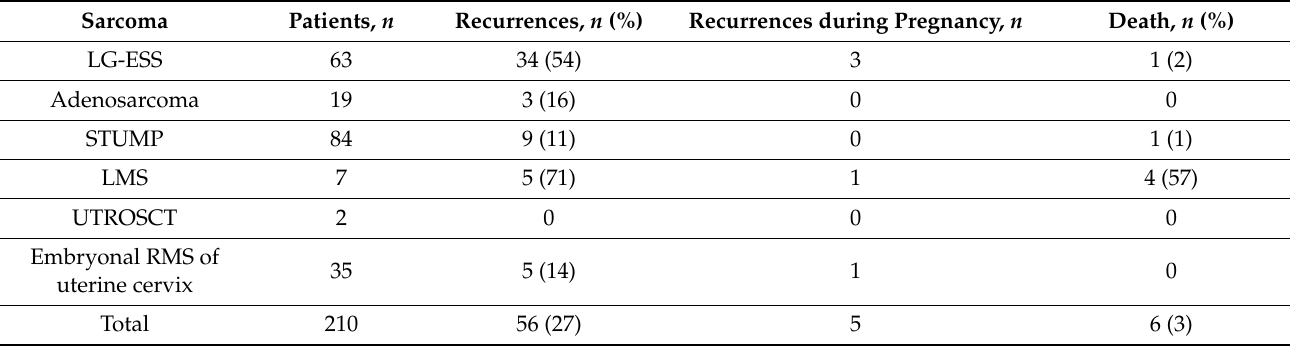
Table 11. Oncologic outcomes after FST of uterine